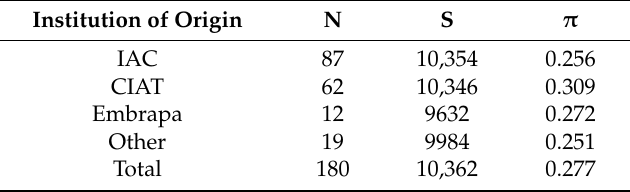
Table 2. Nucleotide diversity in a common bean diversity panel, based on SNPs generated by Ape KI-genotyping by sequencing (GBS) technology. CIAT: International Center for Tropical